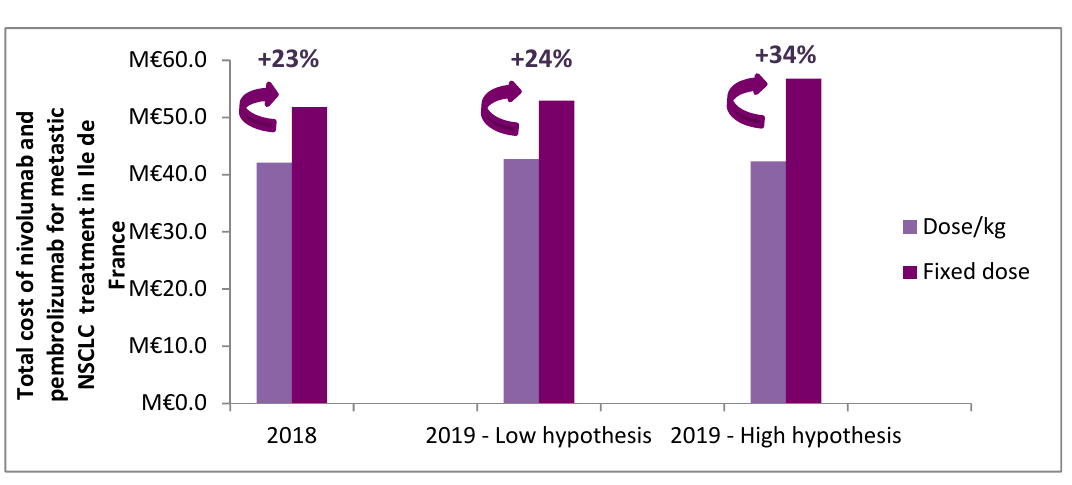
Table 7. Global annual additional cost for the two molecules for the analyzed population.